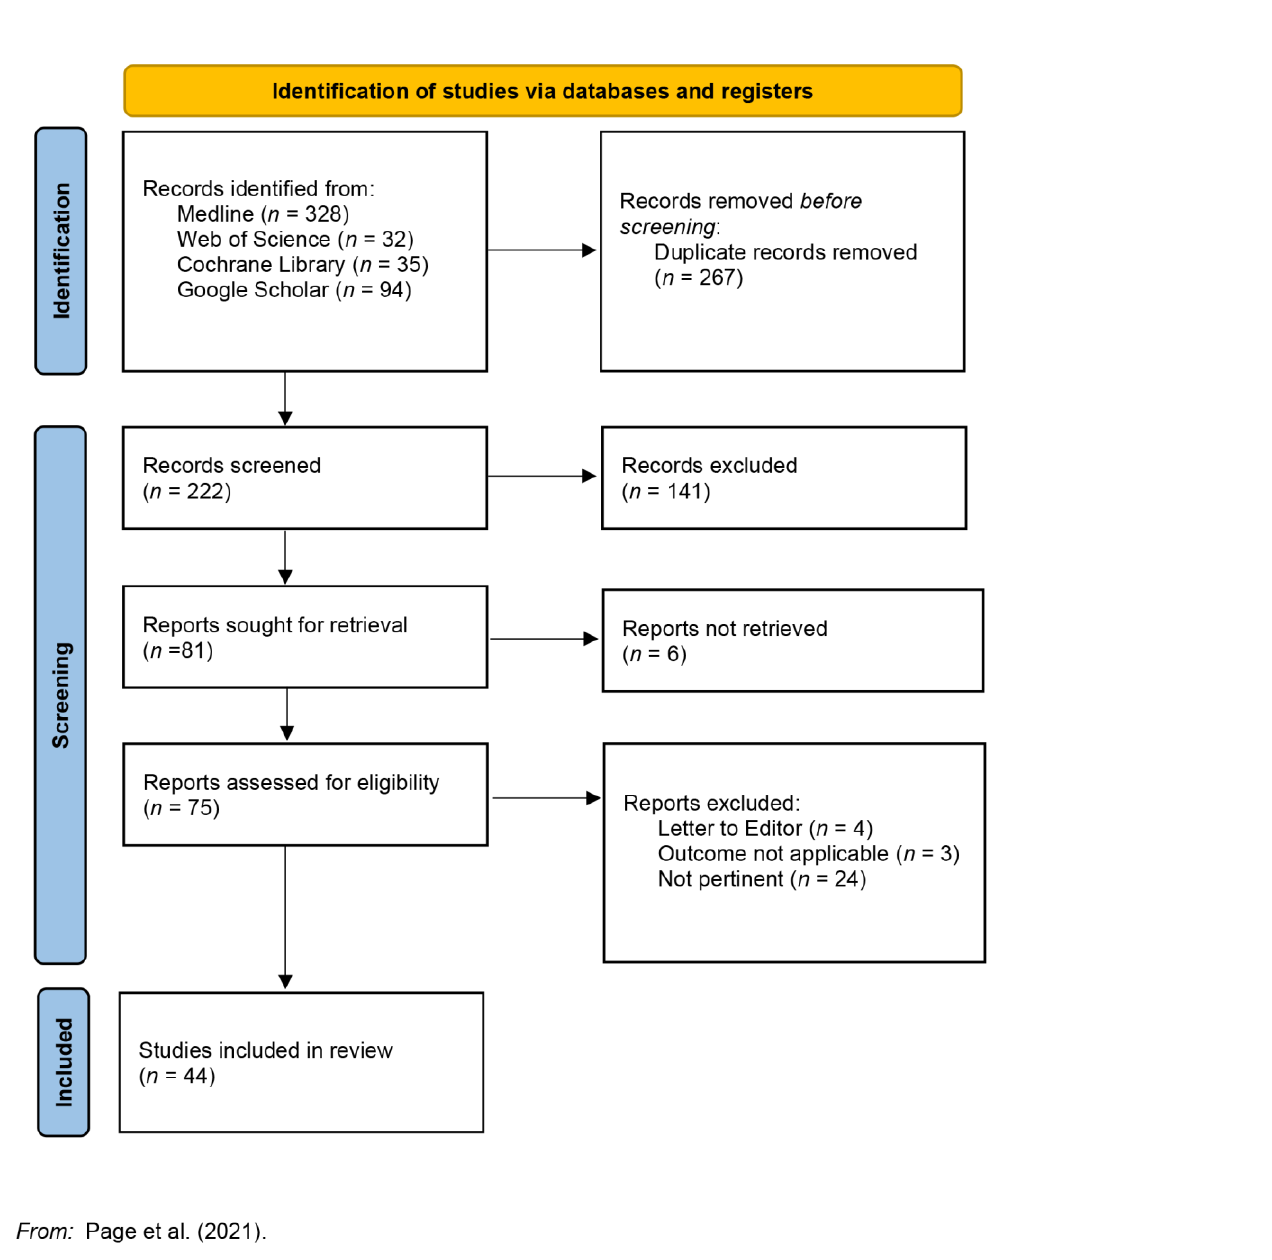
Figure 1. Preferred Items for Systematic Reviews and Meta-Analyses (PRISMA) flow diagram; adapted from Reference [4].